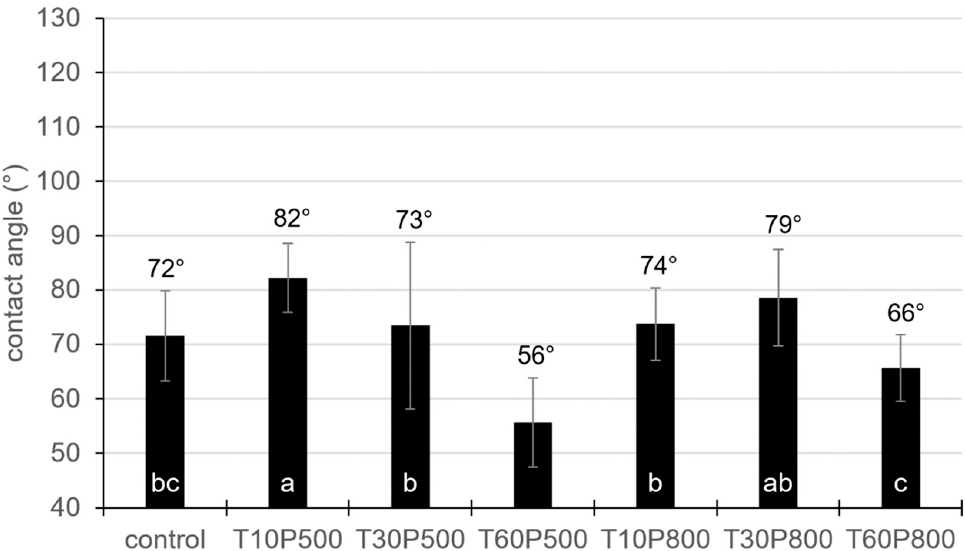
Figure 7. Effect of LPMD treatment on water contact angle on the surface of the sunflower seeds (the same letter signs the variants that are not significantly different; vertical lines denote standard deviation bars).